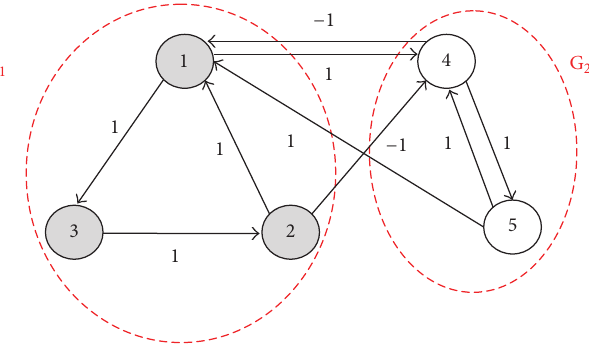
Figure 4: The topology of the multiagent networks